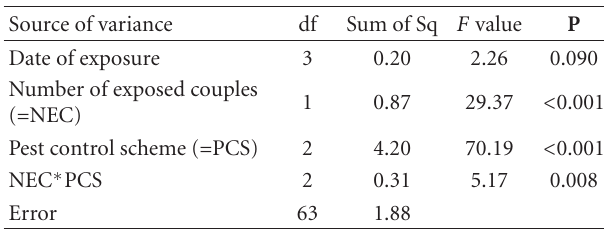
Table 1: ANCOVA table on the e ff ect of date of exposure, number of exposed couples, and mating disruption control scheme on the mating status of E. ambiguella females.